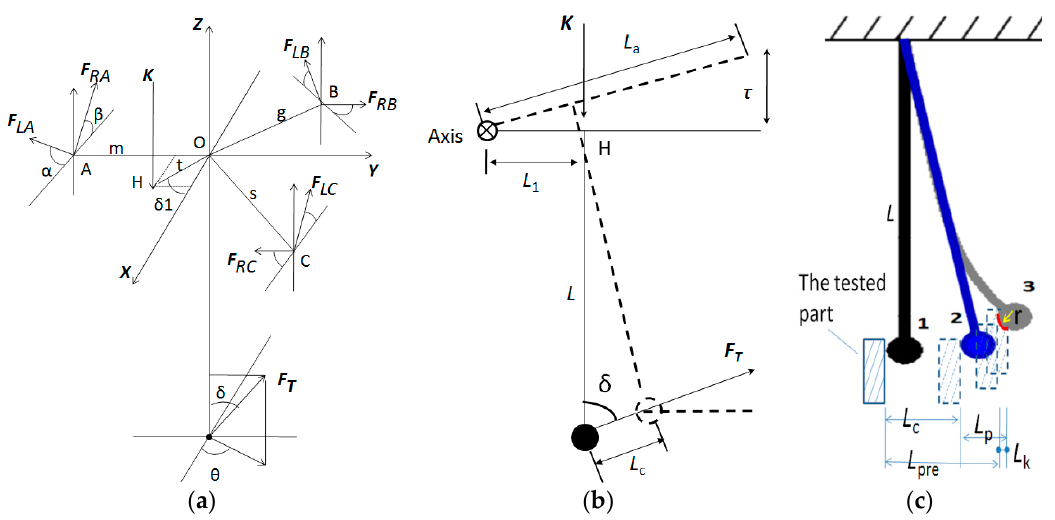
Figure 5. Displacement change and stress analysis diagram of the probe in the process of triggering. ( a ) force analysis in the process of probe triggering; ( b ) equivalent diagram of force and rigid displacement change of the probe in the process of probe triggering; ( c ) displacement change of each stage in the process of probe triggering.